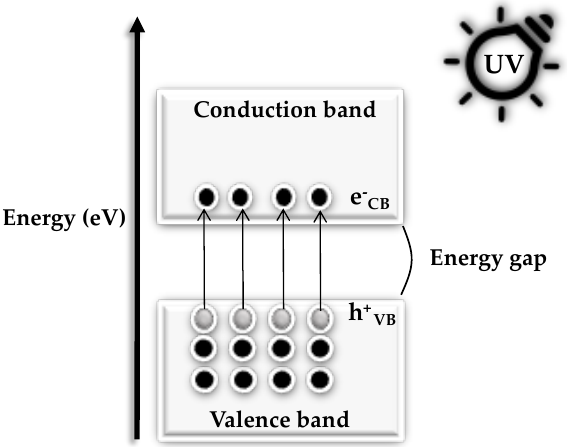
Figure 2. Photoelectrochemical phenomena at TiO 2 exposed to ultraviolet (UV) light. Adapted from reference [8].